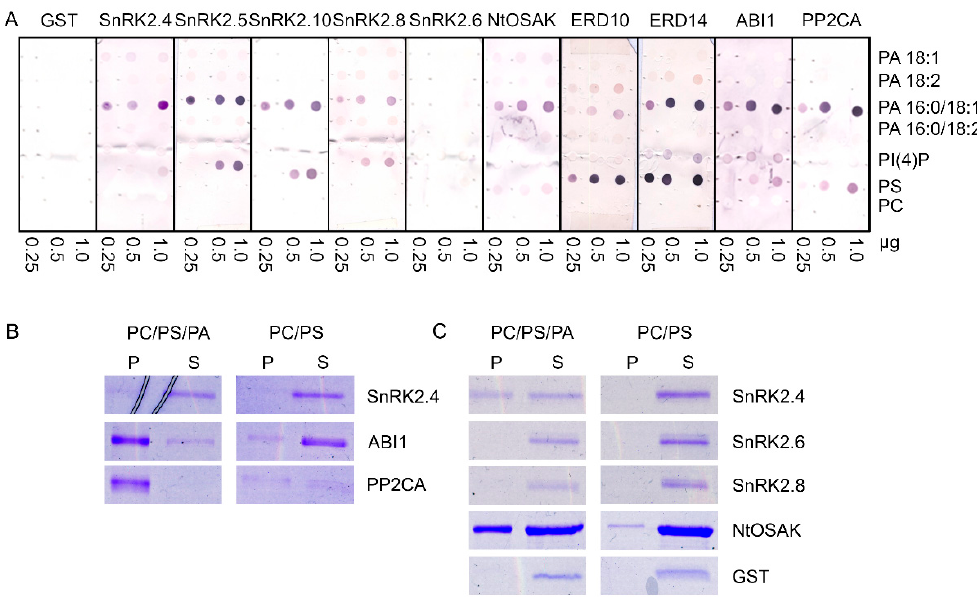
Figure 1. Binding of selected proteins engaged in SNF1-related protein kinase 2 (SnRK2) signaling to phospholipids. The proteins studied were group 1 SnRK2s ( Arabidopsis SnRK2.4, SnRK2.5, SnRK2.10, and tobacco NtOSAK), Arabidopsis SnRK2.8 (group 2), Arabidopsis SnRK2.6 (group 3), the regulatory phosphatases abscisic acid (ABA) insensitive 1 (ABI1) and protein phosphatase 2C A (PP2CA), as well as SnRK2s substrates, the dehydrins Early Responsive to Dehydration 10 (ERD10) and ERD14. The proteins in fusion with glutathione S-transferase (GST) were bacterially expressed and purified. ( A ) Phospholipid blot assay. Phospholipids (0.25, 0.5, 1.0 μ g) were spotted onto nitrocellulose and incubated with 10 μ g/mL of GST fusion proteins. Bound proteins were detected by immunoblotting using anti-GST antibodies. GST was used as a negative control. ( B and C ) Liposome assay. Liposomes composed of phosphatidylcholine (PC)/phosphatidylserine (PS)/phosphatidic acid (PA) 16:0/18:1 (4:1:4.4) or PC/PS (4:1) were incubated with 1.3 μ g of indicated proteins and then pelleted by centrifugation. Proteins in the pellet (P) and supernatant (S) were separated by SDS-PAGE and stained with Coomassie Brilliant Blue. In ( C ), ten-fold more liposomes was used per assay than in ( B ). Data represent one of at least three independent experiments showing similar results.